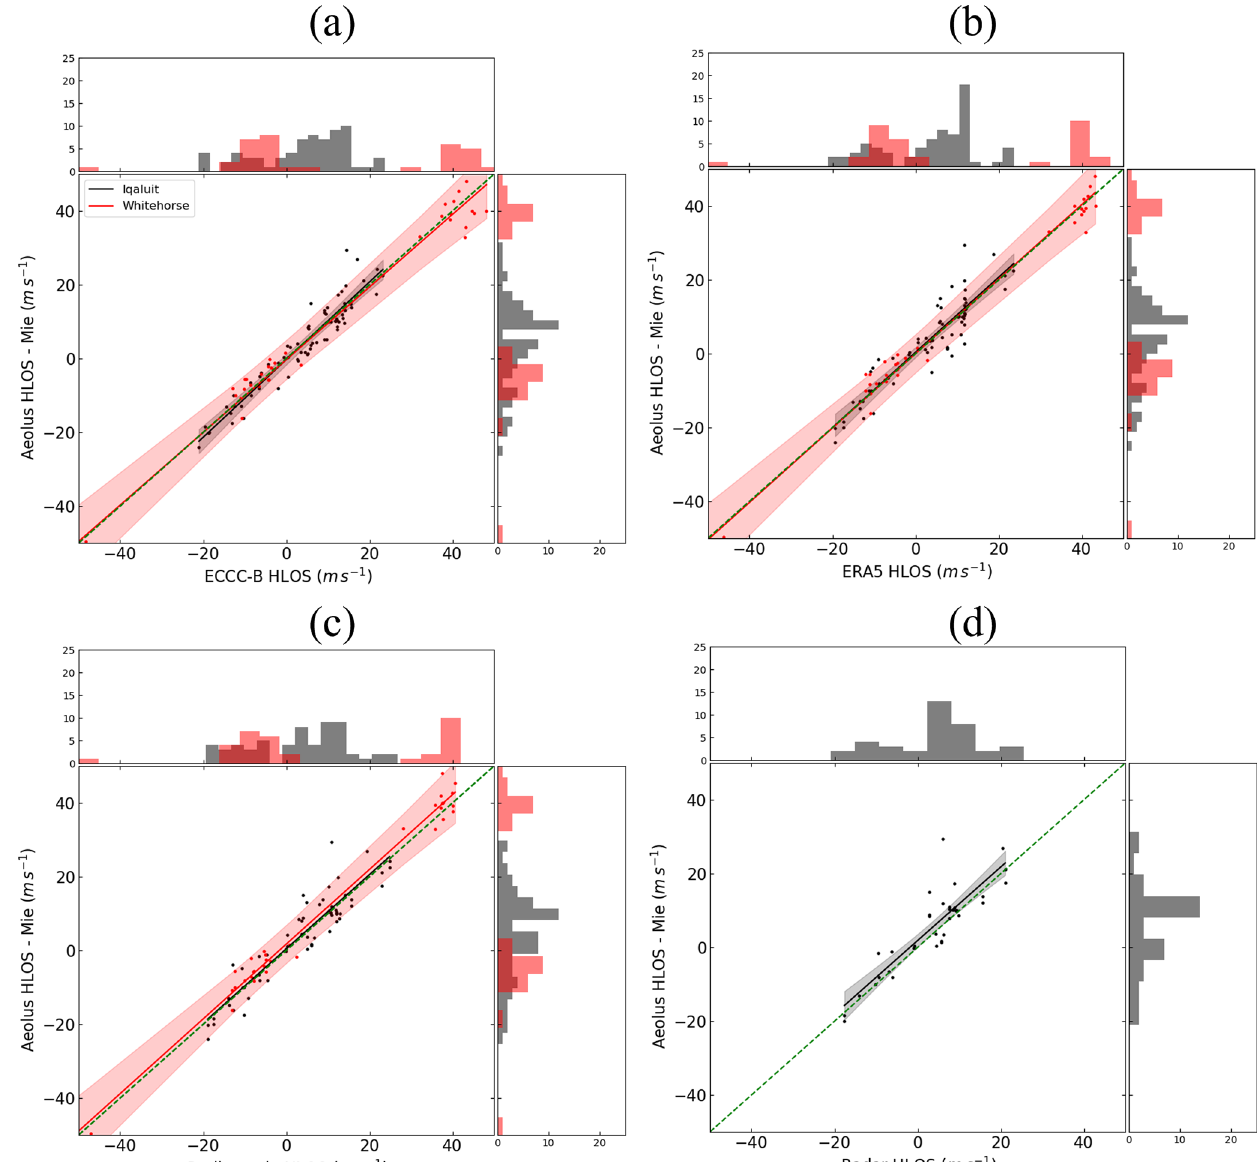
Figure 5. Similar to Fig. 4 but scatter plots between Aeolus Mie winds and other datasets.